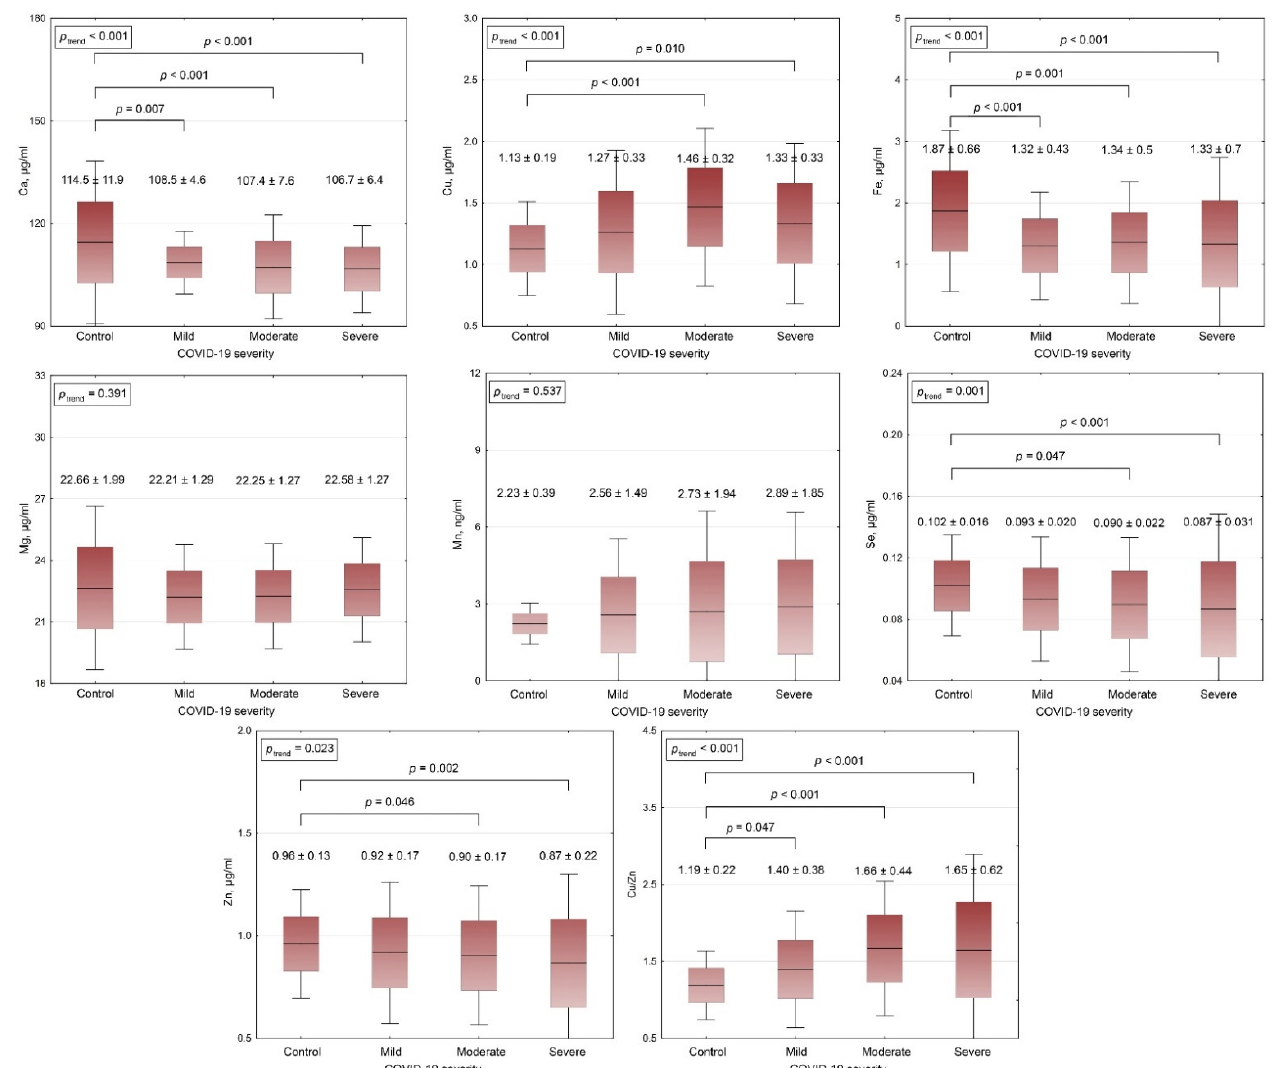
Figure 1. Serum metal levels and Cu-to-Zn ratio in COVID-19 patients in relation to disease severity. Data are expressed as mean ± SD; p values are indicated according to one-way ANOVA Bonferroni’s adjustment.